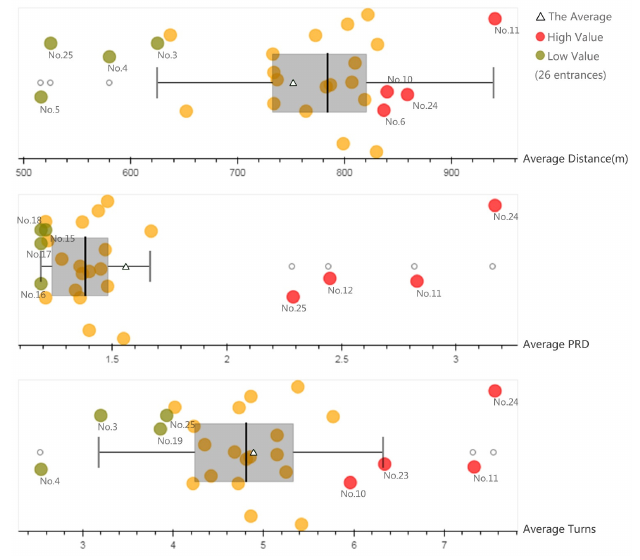
Figure 6. Pedestrian environment of entrances.